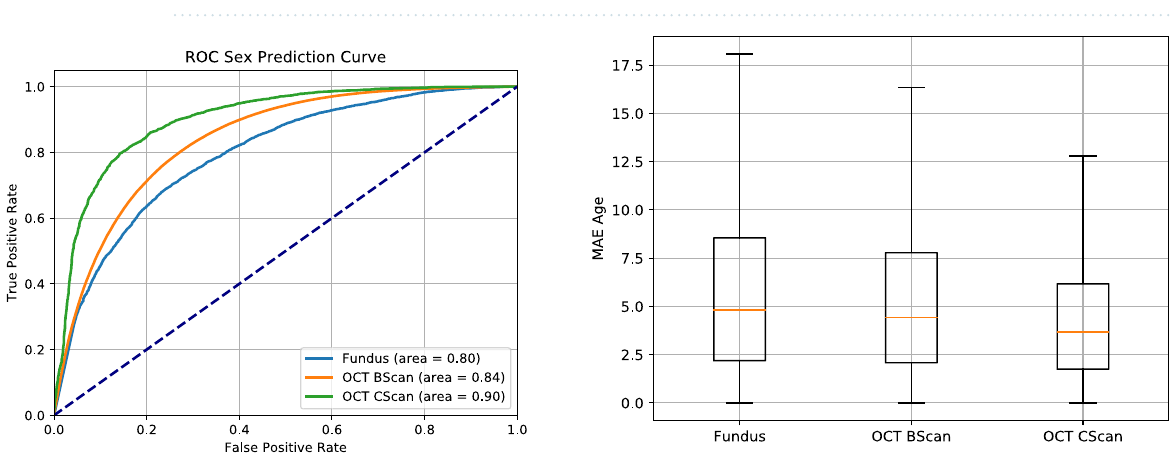
Figure 3. Overview of the CScan method. Features of every independant BScan are extracted using the CNN stage f c . The features are fused using a 2D convolution and classified using a fully connected layers.